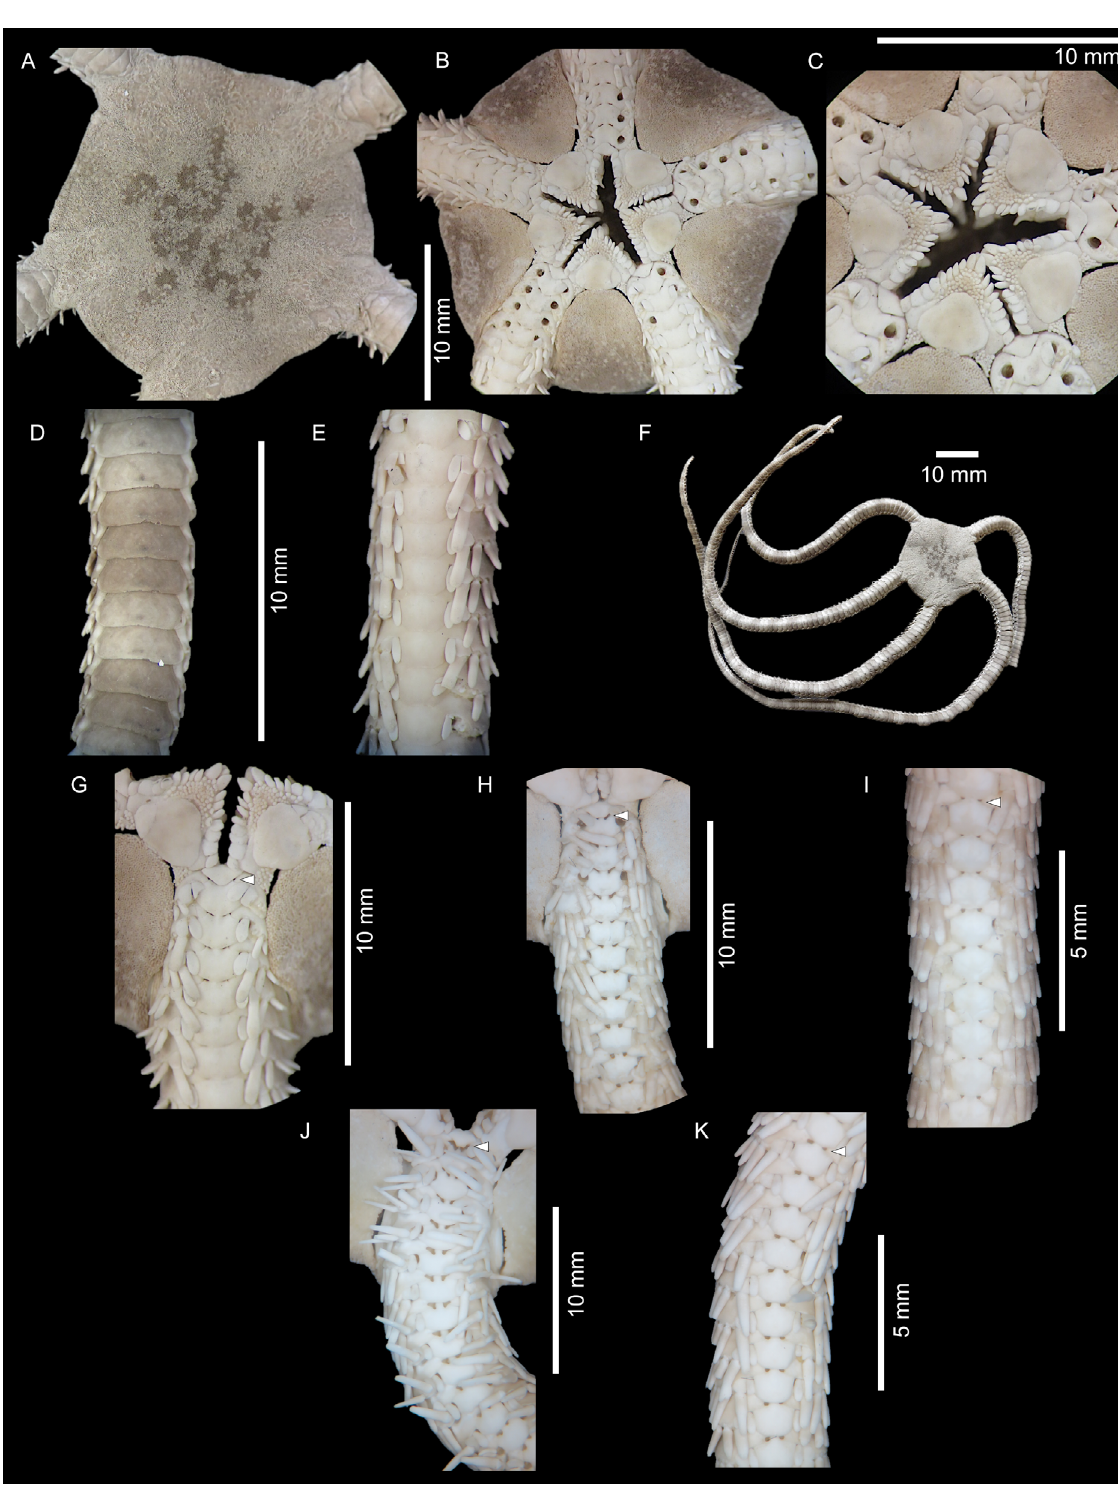
Fig. 7. Ophioderma pentacanthum H.L. Clark, 1917, paratype (A–G = MCZ OPH-4519, DD = 21.1 mm H–I = MZUCR-ECH 1413, DD = 23.0 mm; J–K = MZUCR-ECH 1414, DD = 26.8 mm). A . Dorsal disc. B . Ventral disc. C . Mouth. D . Dorsal arm. E . Ventral arm. F . Dorsal view. G . Pores between proximal ventral arm plates. H . Pores in proximal ventral arm plates. I . Pores in median ventral arm plates. J . Pores in proximal ventral arm plates. K . Pores in median ventral arm